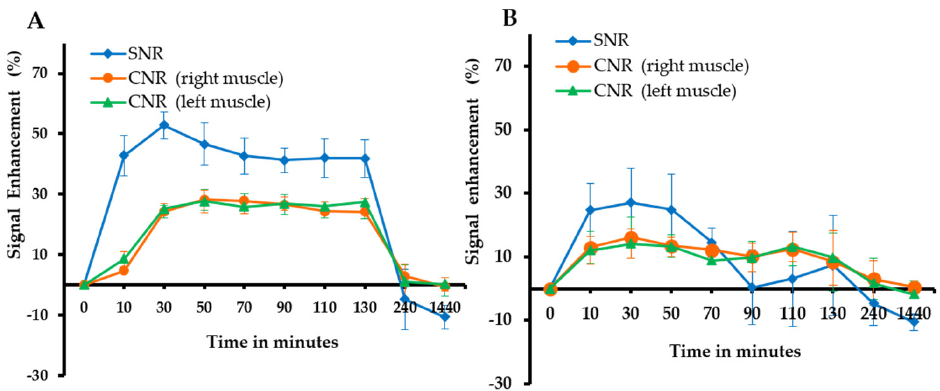
Figure 8. Quantification and comparison of the SNR and CNR in the tumor region measured after the intravenous injection of Gd-DO3A-Am-PBA ( A ) or Gadovist ( B ). Error bars represent mean ± standard error values. SNR: signal-to-noise-ratio; CNR: contrast-to-noise ratio.